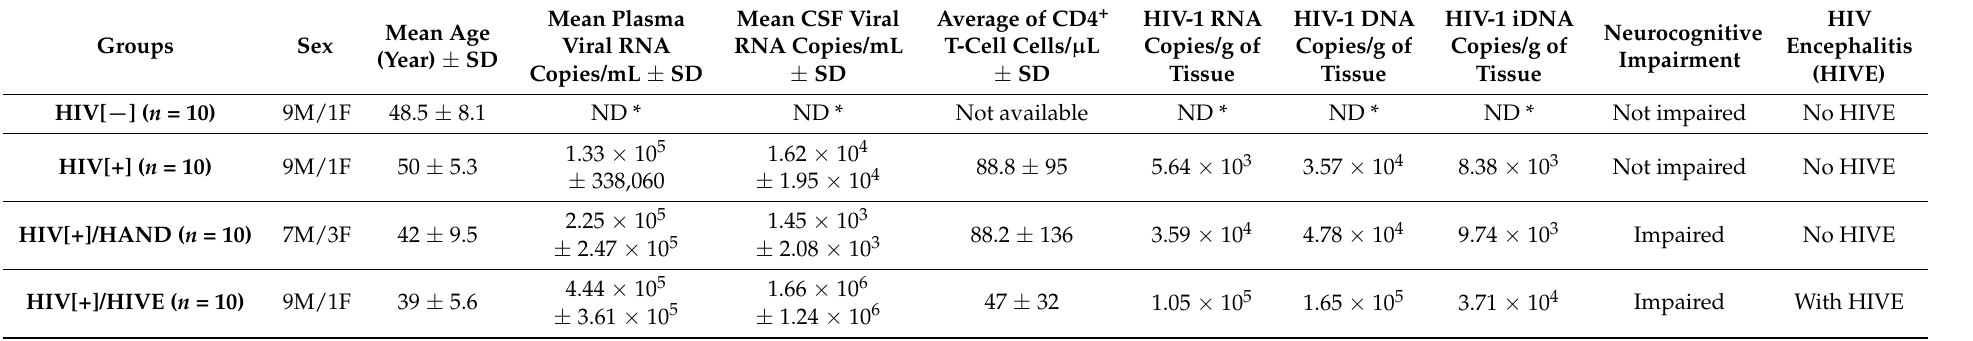
Table 1. Clinical and demographic features of human